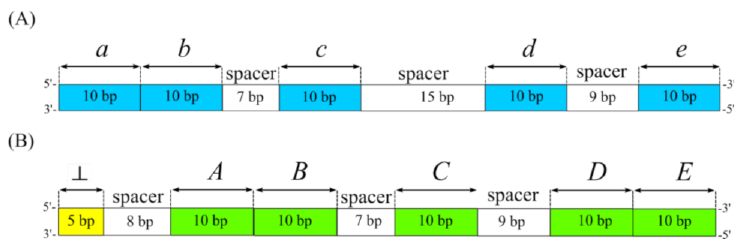
Figure 5. ( A ) An example of the input symbols of a biomolecular queue automaton. ( B ) An example of the queue symbols of a biomolecular queue automaton. Abbreviations: bp—the number of base pairs, encoding information in DNA; 10 bp—the length of a DNA with 10 base pairs (other base pair numbers such as 7 bp are to be understood accordingly); the input symbols of a biomolecular queue automaton are denoted by blue color; the queue symbols of a biomolecular queue automaton are denoted by green color, the empty queue symbol is denoted by yellow